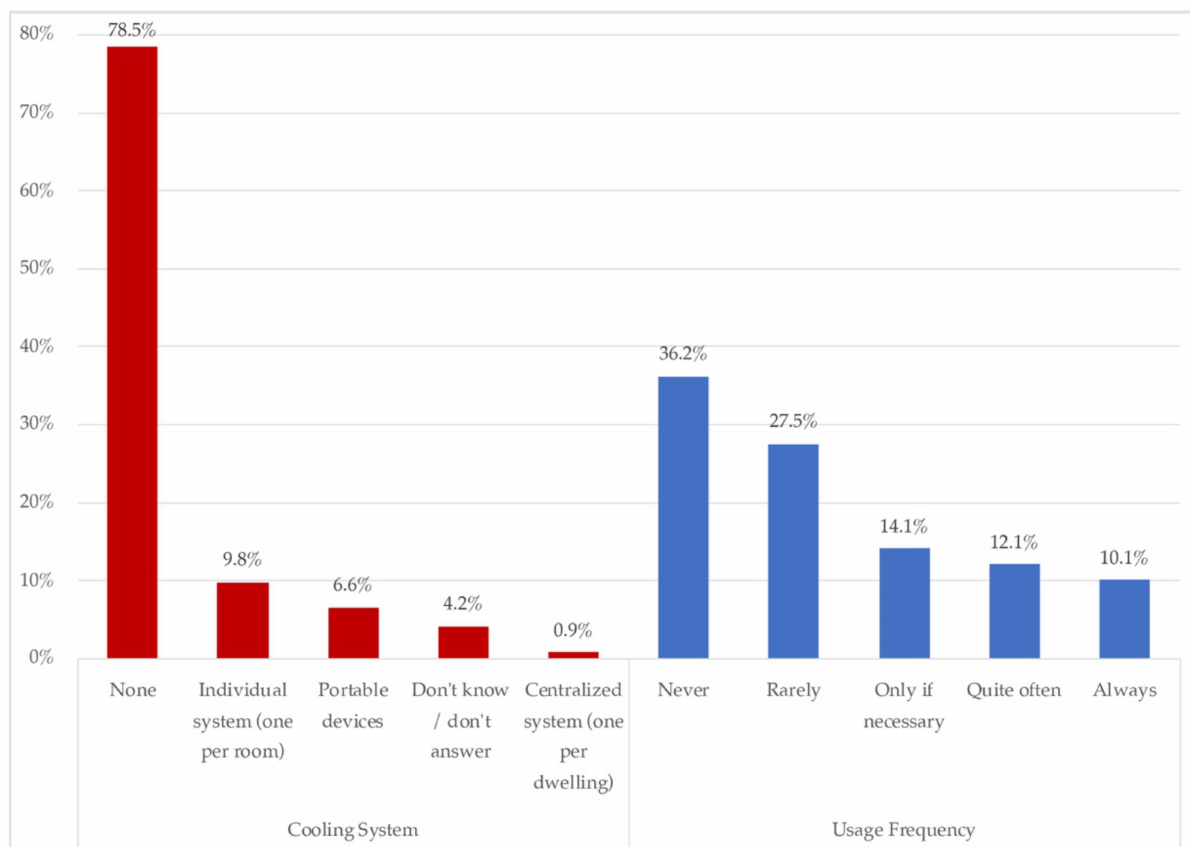
Figure 7. Availability and frequency of use of the cooling